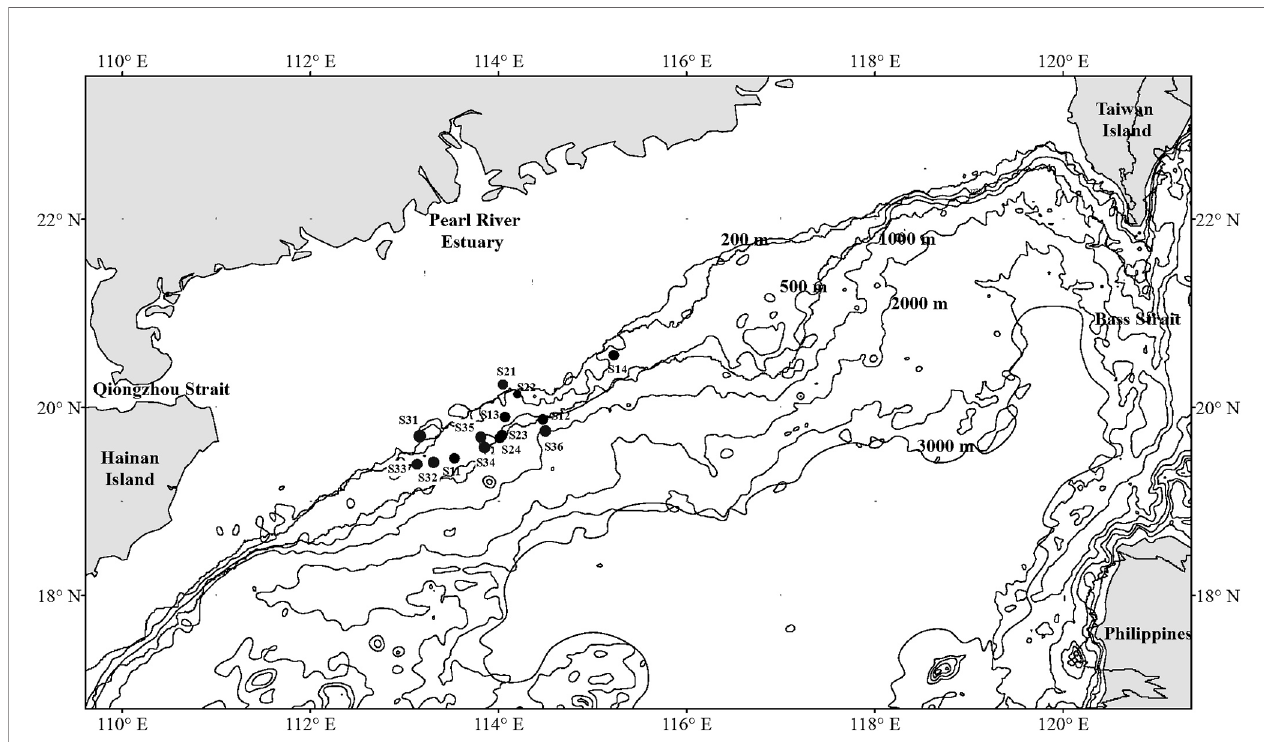
FIGURE 1 | Sampling stations of demersal fi sh over the NCSSCS. Stations S11 – S14 were implemented in June 2015. Stations S21 – S24 were implemented in March 2017. Stations S31-S36 were implemented in September 2018.